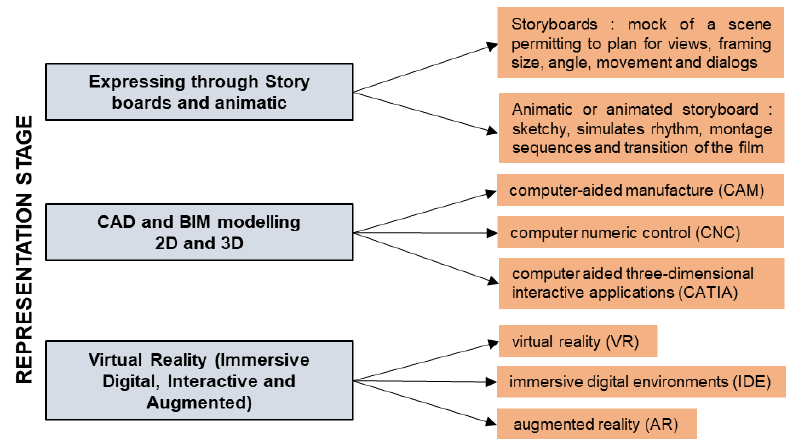
Figure 3. Stage 2: representation in design process (source: created by